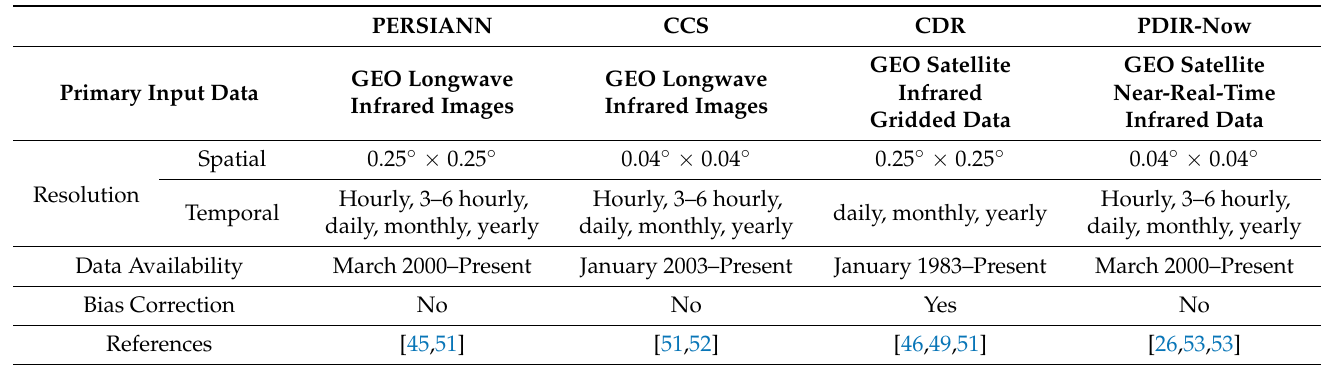
Table 1. Attributes of PERSIANN, PERSIANN-CCS, PERSIANN-CDR and